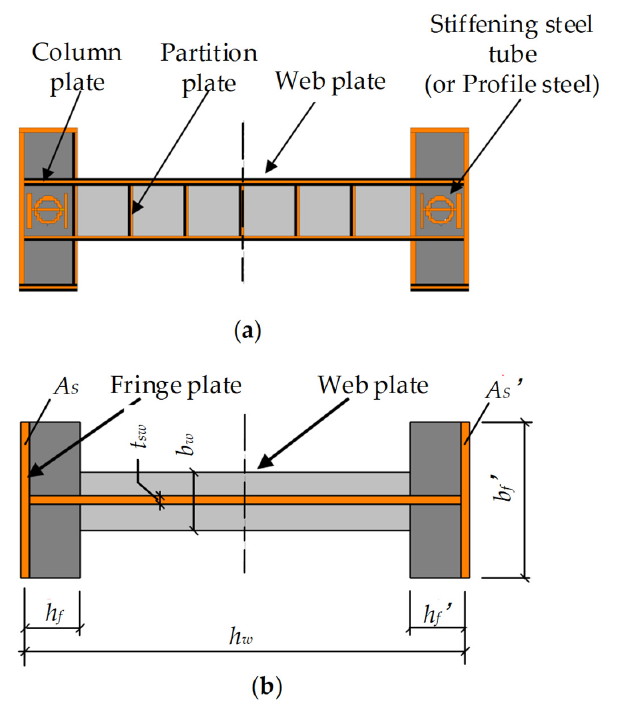
Figure 6. Simplification of the cross section for SC walls. ( a ) The general section structure; ( b ) Cross section simplification.